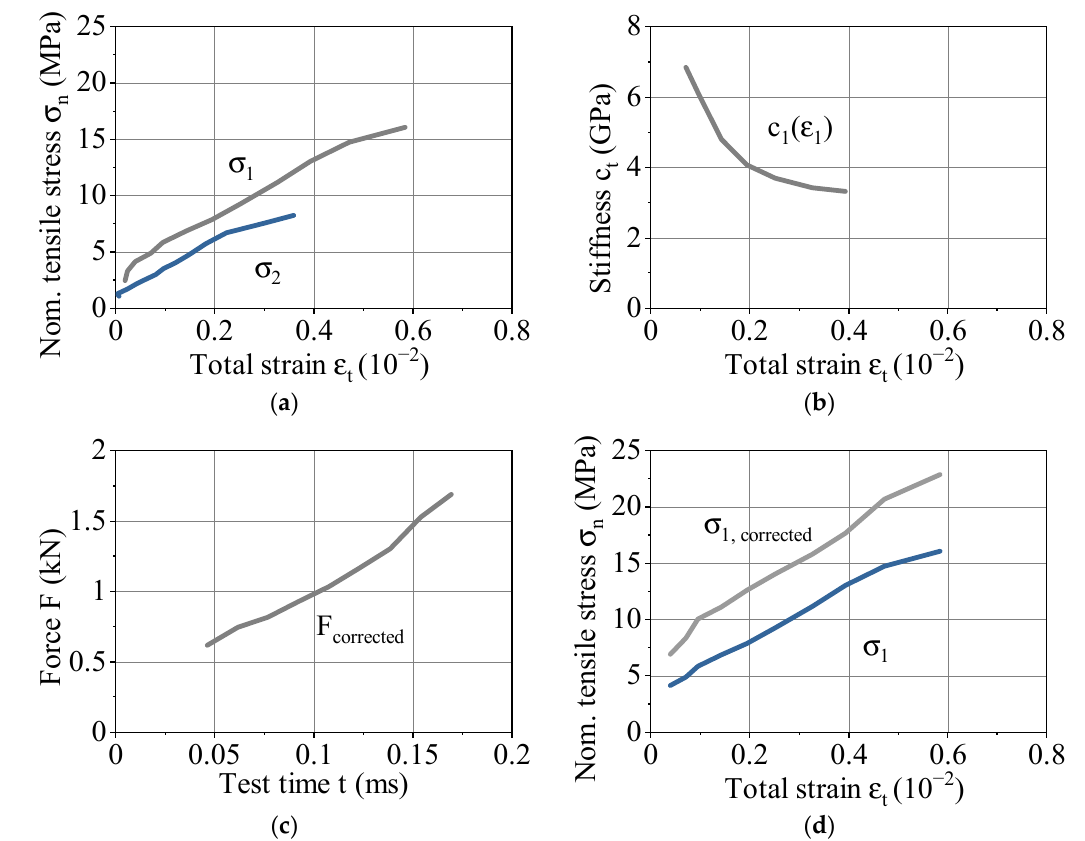
Figure 8. Exemplary data processing for high-speed tensile tests on representative data for LH 0.2 mm at a strain rate of 250 s − 1 : ( a ) stress vs. strain diagram with raw data including oscillations for testing and dynamometer section; ( b ) stiffness vs. strain out of the testing area; ( c ) corrected force vs. time for the entire test; ( d ) corrected stress vs. strain diagram in the testing area.